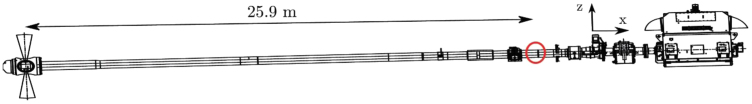
Location of strain gauges mounted along the shaft line.